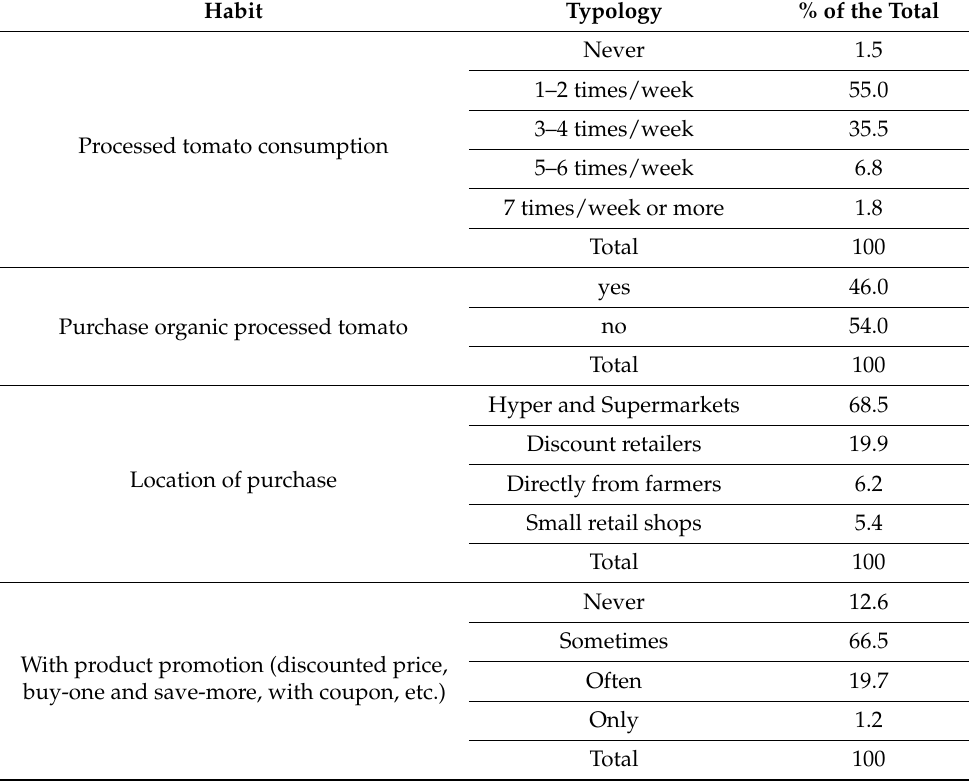
Table 3. Processed tomato consumption and purchasing habits of the respondents.